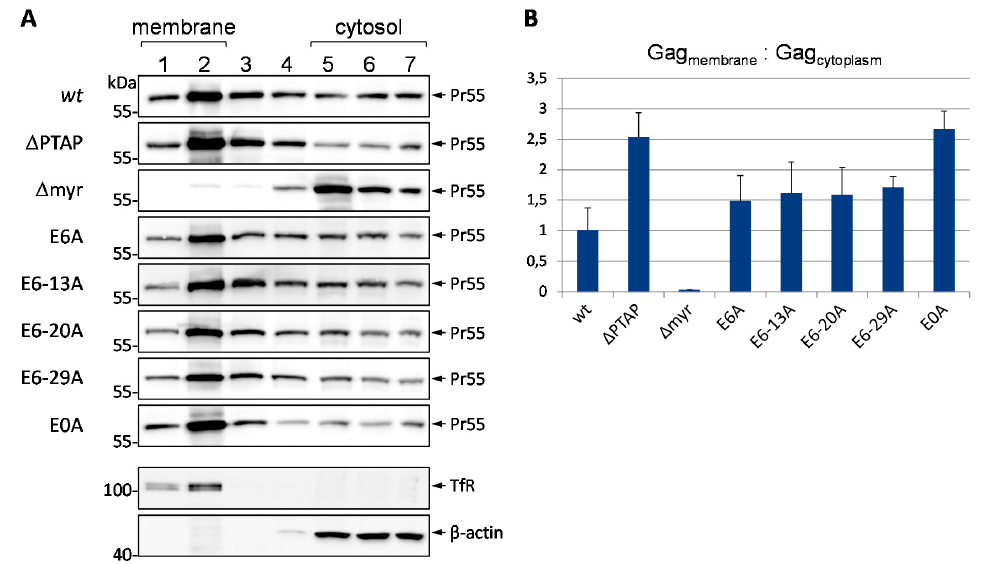
Figure 9. The mutations of Glu residues increase the membrane association of Pr55 Gag. ( A ) HeLa cells were transfected with syngag expression constructs coding for wt Gag, the p6 mutants ∆ PTAP, E6A, E6-13A, E6-20A, E6-29A, E0A or the MA G2A mutant ( ∆ myr). The cells were lysed by sonication and membrane flotation was performed. The fractions were collected and analyzed by western blot stained for CA. The western blots were reprobed with antibodies specific for β -actin and the transferrin receptor (TfR) to determine the cytosolic or membrane fractions, respectively. One representative (1 and 2) vs. the cytosolic fractions (5 to 7) was calculated. Values on the y -axis were adjusted to 1 for wt . Bars represent the mean values of at least 3 independent experiments ˘